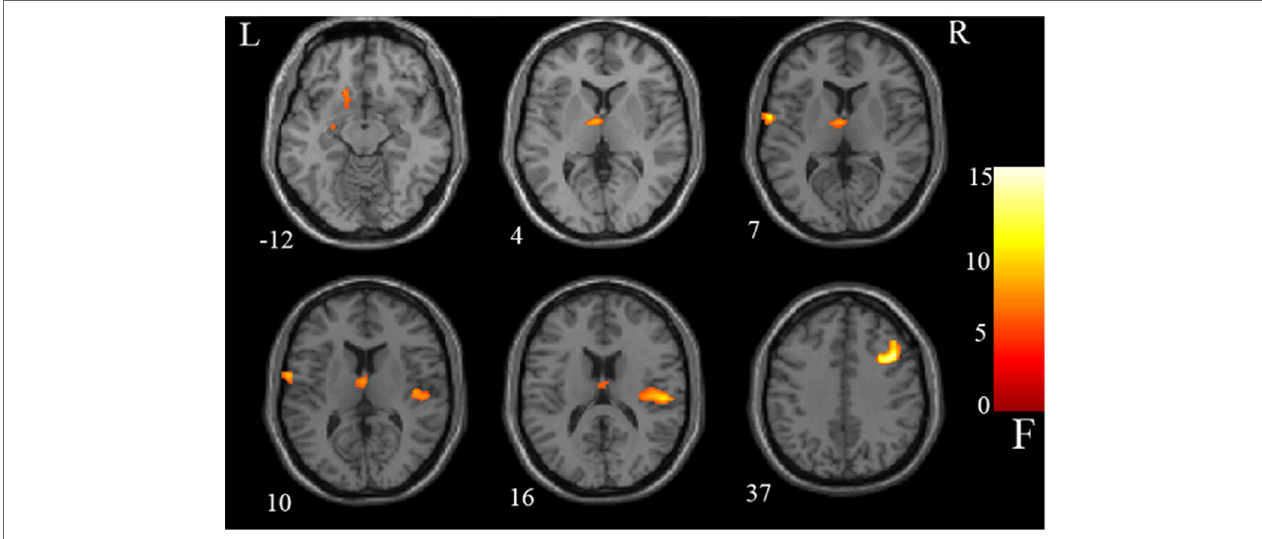
FigUre 1 | Group difference: analysis of covariance results. Gray matter differences between three groups were detected in the left putamen, left caudate, left thalamus, left Rolandic operculum, right Heschl, right Rolandic operculum, and right middle frontal gyrus. Statistical inferences were made with a voxel-level statistical threshold ( p < 0.05) after false discovery rate correction for multiple comparisons. The color bar represents the range of F values.